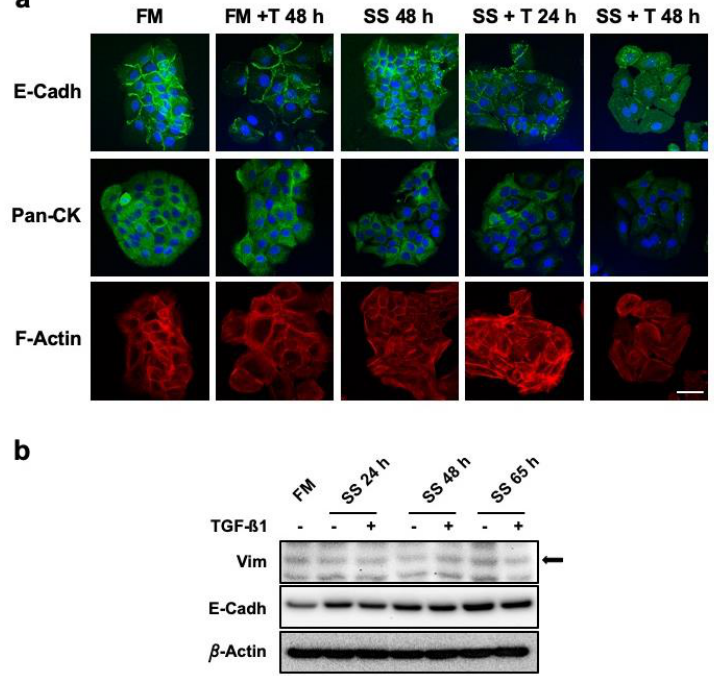
Figure 3. HaCaT keratinocytes do not experience EMT in response to continuous TGF- β 1 exposure. ( a ) Confocal microscopy studies on the expression and localization of structural markers E-Cadherin (E-Cadh), Citokeratins (Pan-Ck), and actin filaments (F-Actin) with, or without, TGF- β 1. Scale bar: 50 µ m. (b) Protein levels of Vimentin (Vim) and E-Cadherin (E-Cadh) were assessed by Western Blot. Total protein extracts from HaCaT cells cultured for the indicated times in SS conditions, with or without TGF- β 1, were compared to control sample (FM). β -Actin was used as protein loading control. Arrow indicates the correct identity of protein bands. Representative images of at least three independent experiments are shown. FM: full medium; SS: serum starvation; + T24 h, + T48 h: time (hours) of continuous TGF- β 1